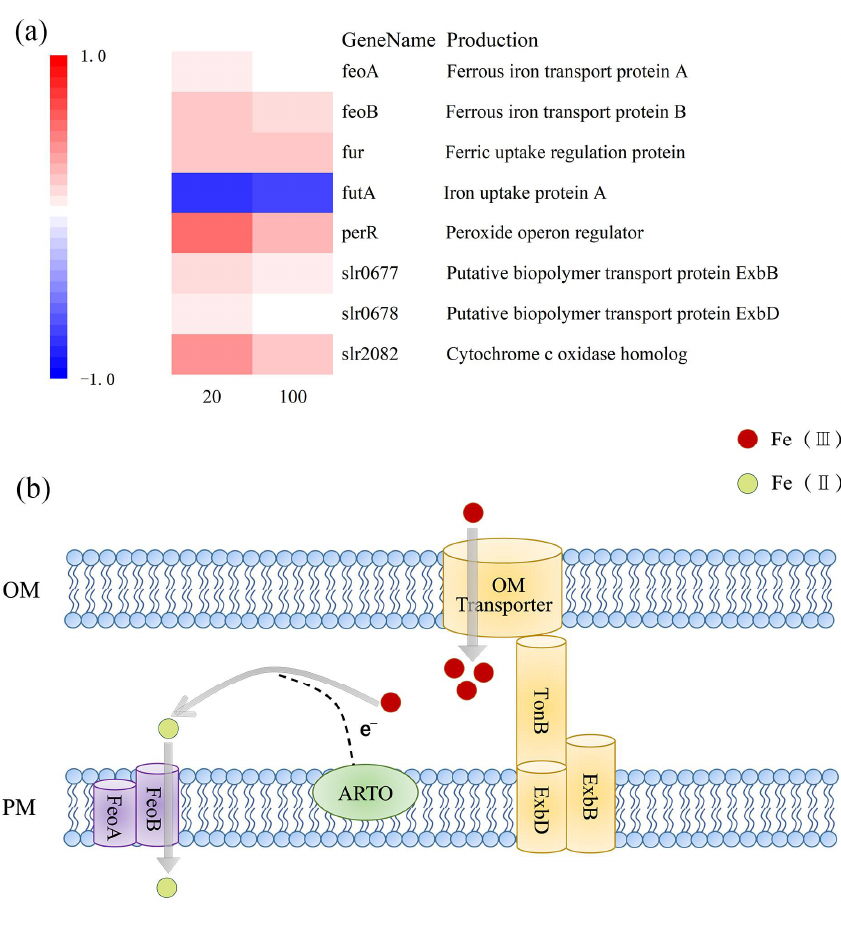
Figure 2. ( a ) Heat map of genes related to iron absorption and transport. Blue corresponds to a decrease in transcript abundance, and red corresponds to an increase in transcript abundance. White means no difference from the control condition; ( b ) schematic diagram of the iron absorption pathway. Fe(III) is first transported through the outer membrane (OM) of the cell (yellow), the respiratory terminal oxidase, ARTO (green), is involved in Fe(III) reduction before transport through the plasma membrane (PM). Fe(II) is transported through FeoB (purple).